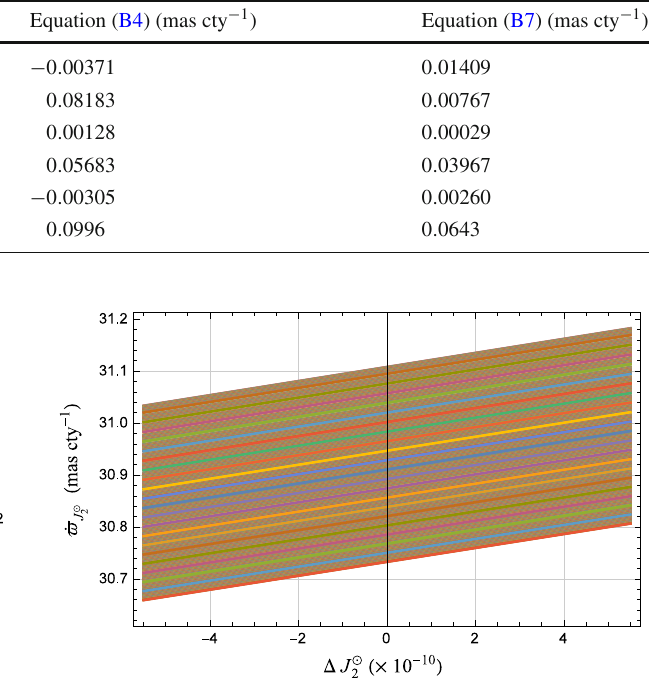
Fig. 2 Family of parametric plots of ˙ (cid:2)